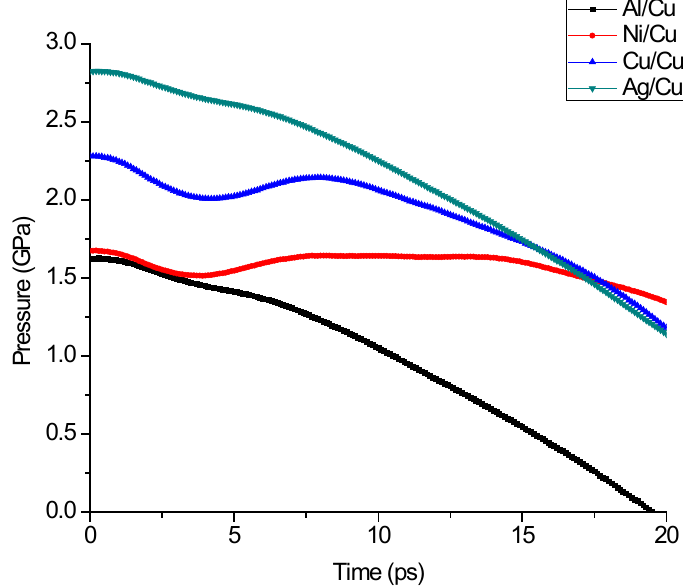
Figure 2. The pressure wave evolution at the periphery of the particle/substrate interfacial region at 1000 m/s of single-particle impact.